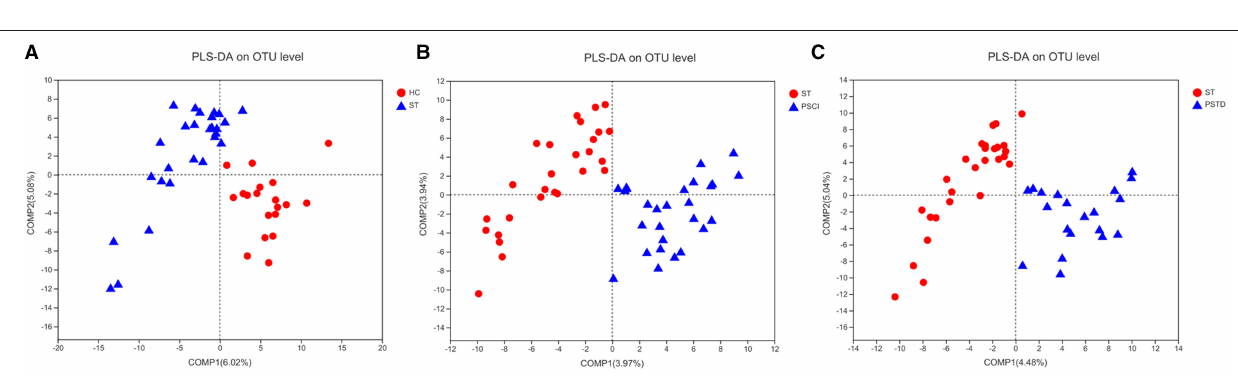
FIGURE 8 | PLS-DA based on OTUs revealed a separation between the (A) ST vs. HC, (B) PSCI vs. ST and (C) PSTD vs. ST groups in the first two principal component